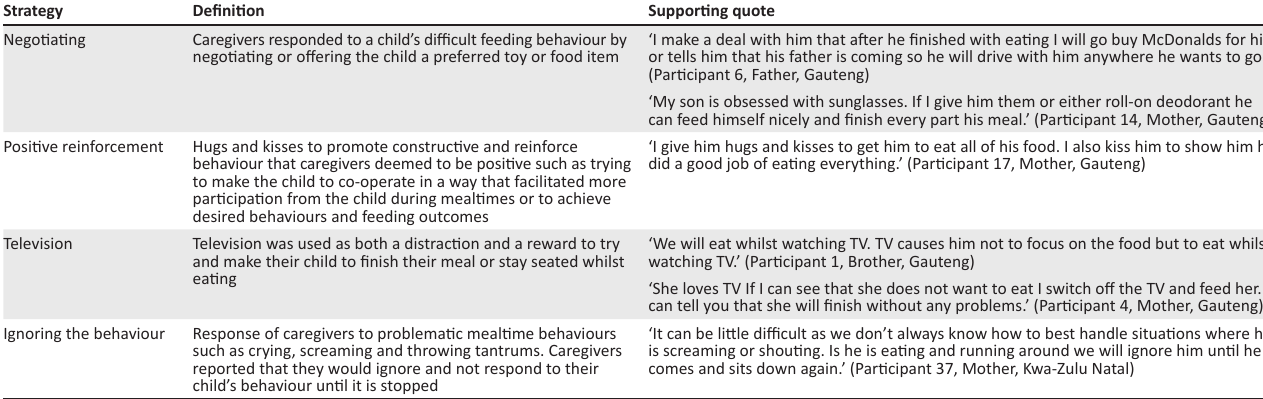
TABLE 3: Mealtime strategies used by caregivers to manage feeding difficulties in children with autism spectrum disorder. Strategy Definition Supporting quote